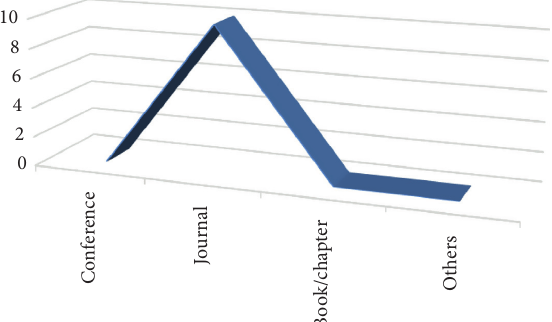
Figure 8: Types of papers with the total number of articles.